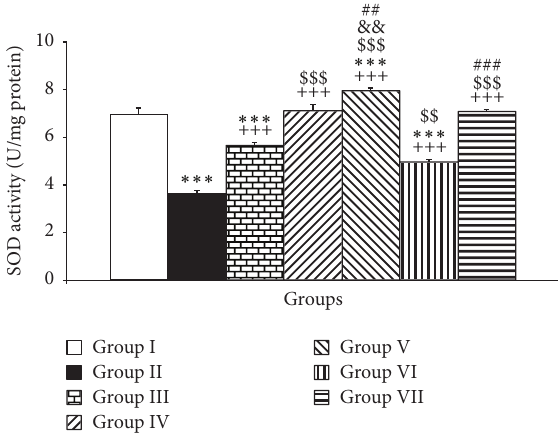
Figure 3: The effects of PTU, Vit E, pioglitazone, and rosiglitazone on cerebellar thiol contents. Data are presented as mean ± SEM; 𝑛 = 7 . ∗∗∗ 𝑃 < 0.001 versus group I; +++ 𝑃 < 0.001 versus group II; $$$ 𝑃 < 0.001 versus group III; & 𝑃 < 0.05 and && 𝑃 < 0.01 compared to IV; # 𝑃 < 0.05 and ## 𝑃 < 0.01 compared to VI. The data from different treatment groups were compared by using one way ANOVA followed by post hoc LSD test. Group I (control), the animals received drinking water; group II, the animals received 0.05% propylthiouracil (PTU) in drinking water; besides PTU, the animals in groups III, IV, V, VI, and VII were injected with 20mg/kg vitamin E (vit E), 10 or 20 mg/kg pioglitazone, and 2 or 4mg/kg rosiglitazone, respectively.